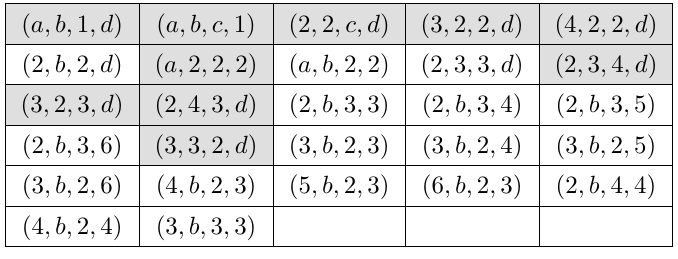
Table 14 . Infinite sequences of type VIII singularities. The gray entries are either reducible to previous types or have at least one of c, d = 1 , which gives trivial 1-form symmetry. This table is adapted from